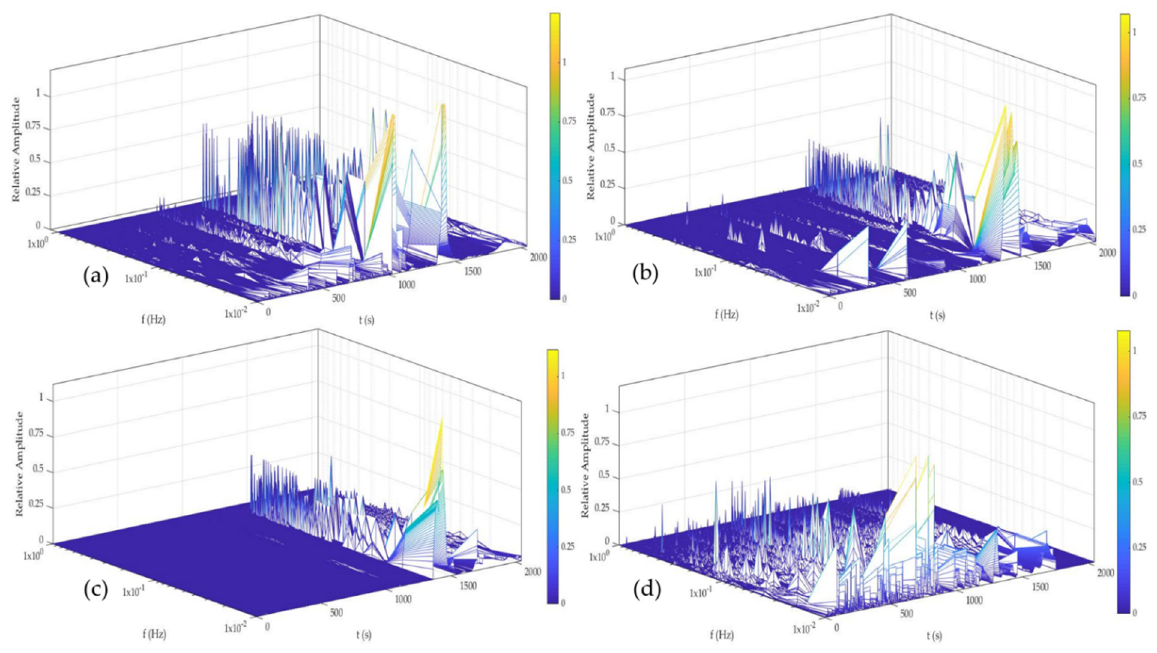
Figure 15. Hilbert spectra of Al-A.M. in H 2 O solution ( a ) 0 h, ( b ) 24 h, ( c ) 48 h, and ( d ) 120 h. Figures 16 and 17 show the time–frequency–energy spectra generated by HHT in NaCl. Al-6061, in Figure 16, presented a behavior related to the diffusion of pitting. The sample presented energy at high and low frequencies (1 × 10 0 and 1 × 10 − 1 Hz) but increased a low frequency (1 × 10 − 2 ). The behavior at 0 and 24 h was related to the process of high frequencies being (pitting) diffused. At 48 and 120 h (Figure 16c,d), the behavior was similar and associated with the pitting diffusion at 0 and 24 h. Al-A.M. showed (Figure 17a–d) a behavior of pitting diffusion.